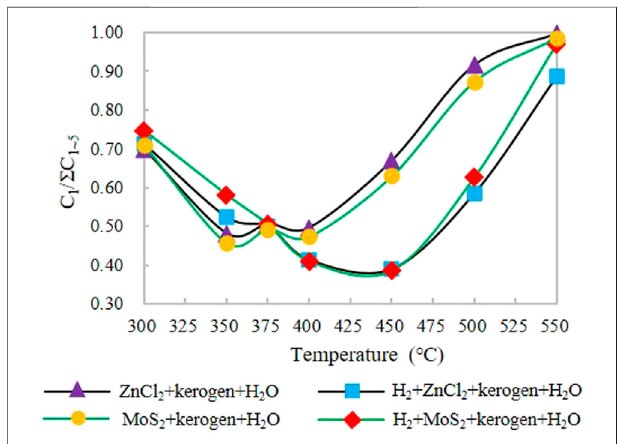
FIGURE6| CharacteristicsofC 1 / (cid:1) C 1-5 contrastunderdifferentcatalytic